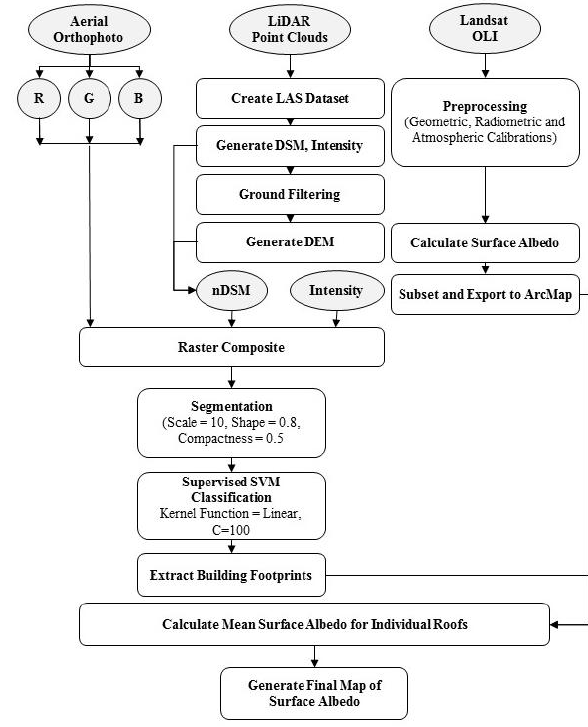
Figure 2. Overall methodology applied to quantify surface albedo of roofs in the current